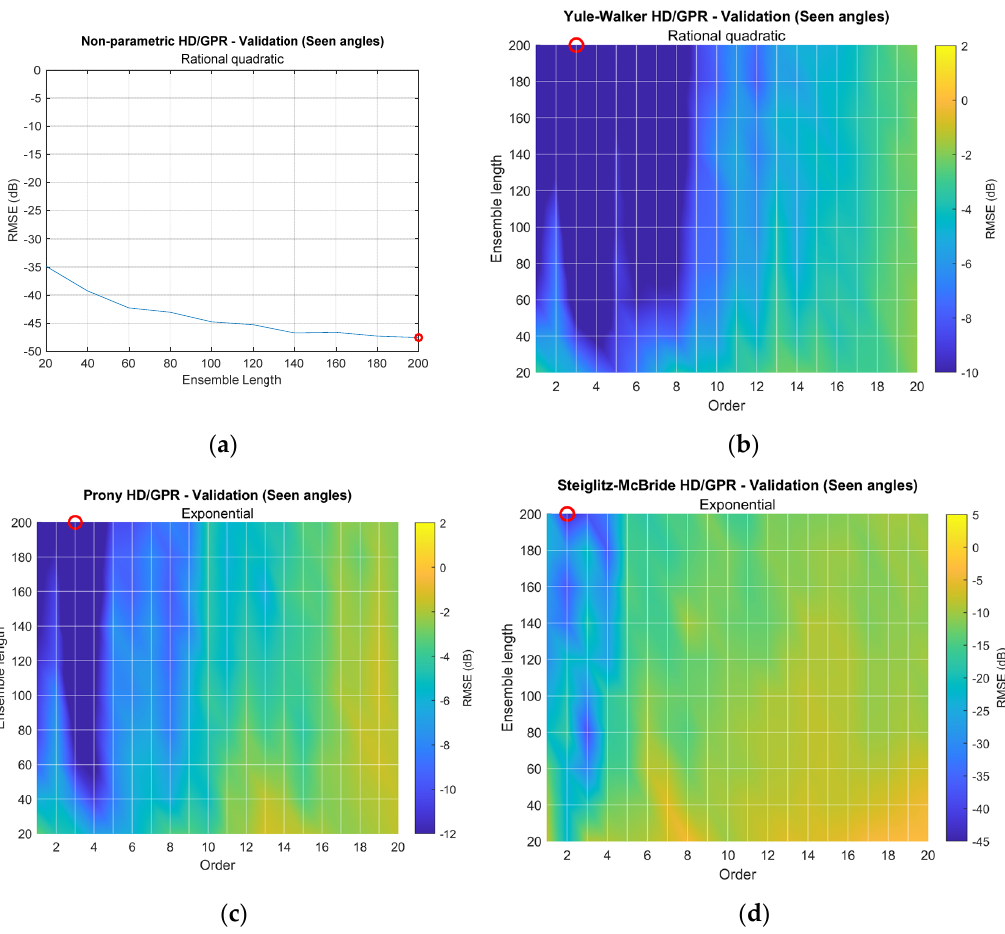
Figure 14. Experimented RMSE distribution for selected kernel functions. The red circle indicates the minimum RMSE location. (Training: 999 iterations; and validation seen-angle: 999 iterations.) ( a ) Nonparametric HD/GPR—Validation (seen angles); ( b ) Yule–Walker HD/GPR—Validation (seen angles); ( c ) Prony HD/GPR—Validation (seen angles); ( d ) Steiglitz–McBride HD/GPR –Validation (seen angles).